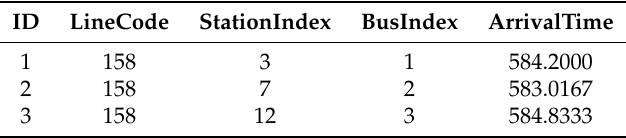
Table 1. Illustration of arrival data stored in the “ArrivalData”